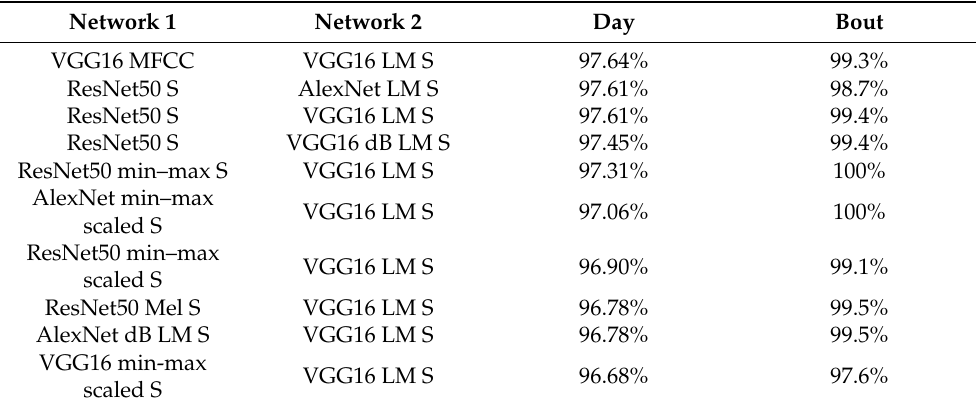
Table 2. Performance Accuracy of the 2-Ensemble on the ERR Day and ERR Bout Datasets (sorted by performance).